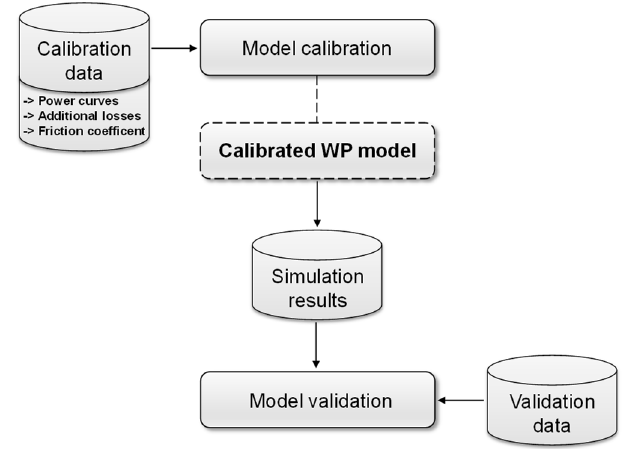
Figure 4. Scheme of the development process of the wind power (WP) model. The internal structure of the simulation model is depicted in Figure 5. The plant and weather data in this flowchart represent the input data for the calibrated wind power model. The required calculation steps of the simulation model are displayed as rectangles and all the other symbols have the same meaning as described for Figure 4.